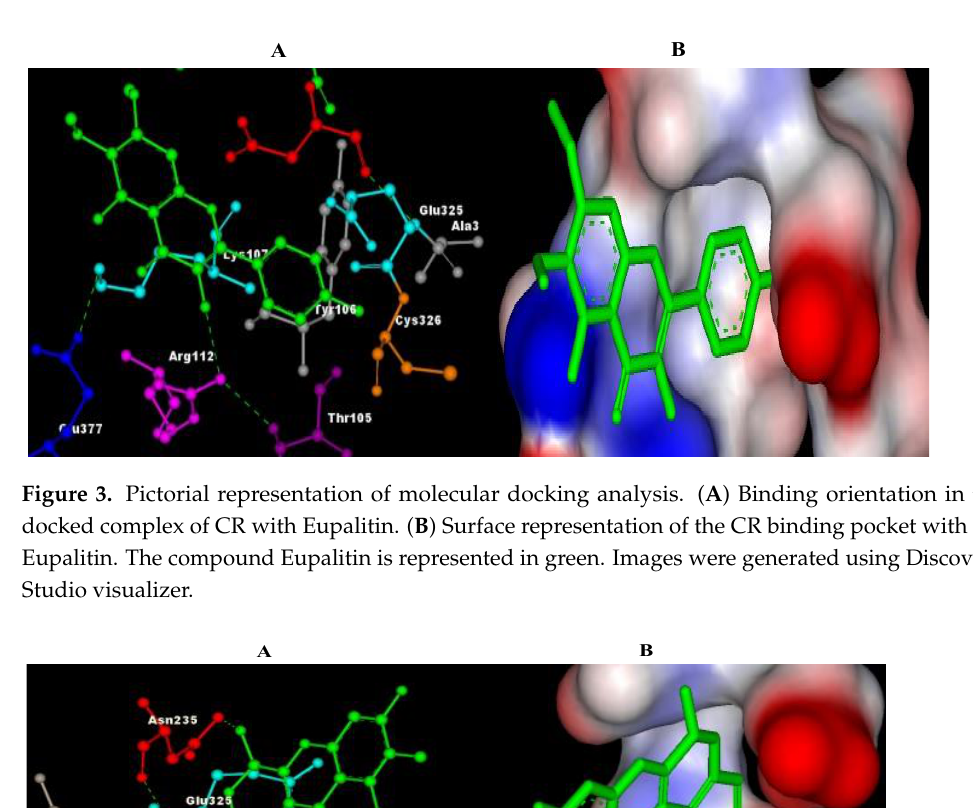
Figure 2. The docked complexes of selected compounds ( A ) Sibutramine, ( B ) Boeravinone B, ( C ) Eupalitin, and ( D ) Punarvavine with Cannabinoid receptor.